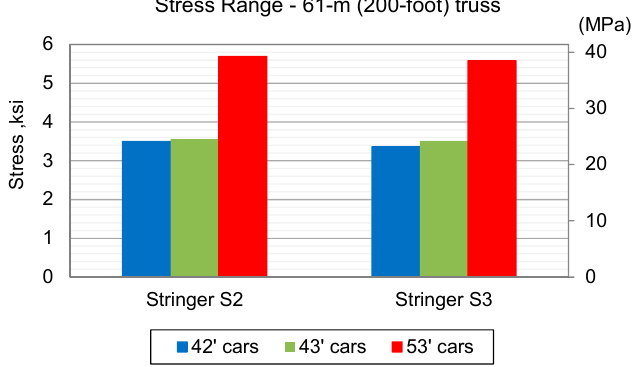
Figure 17. Typical peak stress calculated from measured strains, comparisons for stringers.